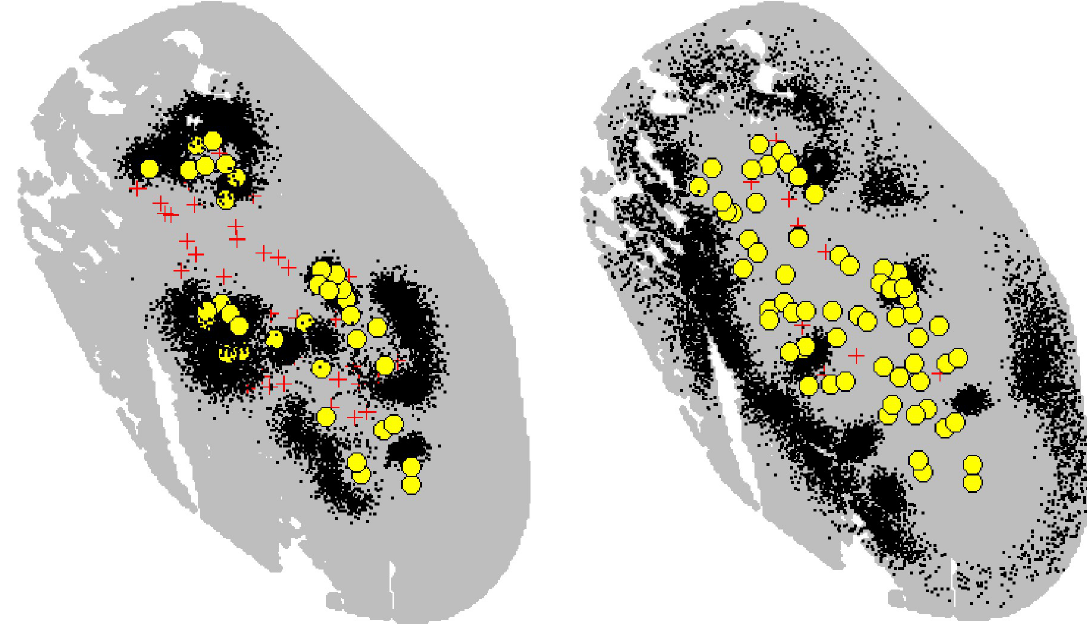
Fig 6. Activity centre posterior distributions (black dots); capture locations (yellow circles); and trap locations (red crosses) for all recorded adult females (left) and adult males (right), in the winter.